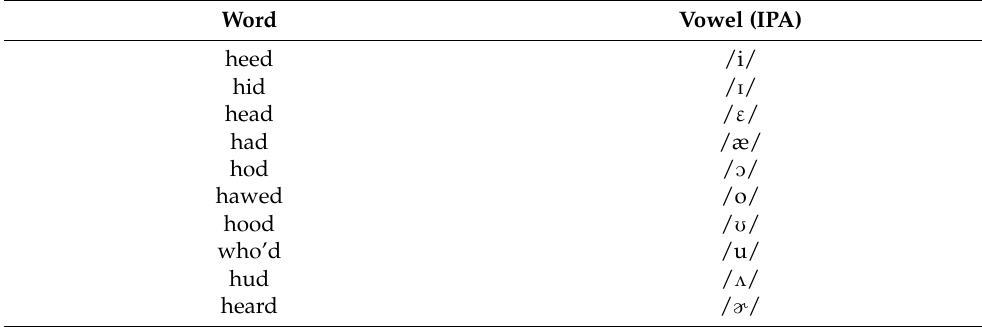
Table 3. English word list with the corresponding target vowels (after Hillenbrand